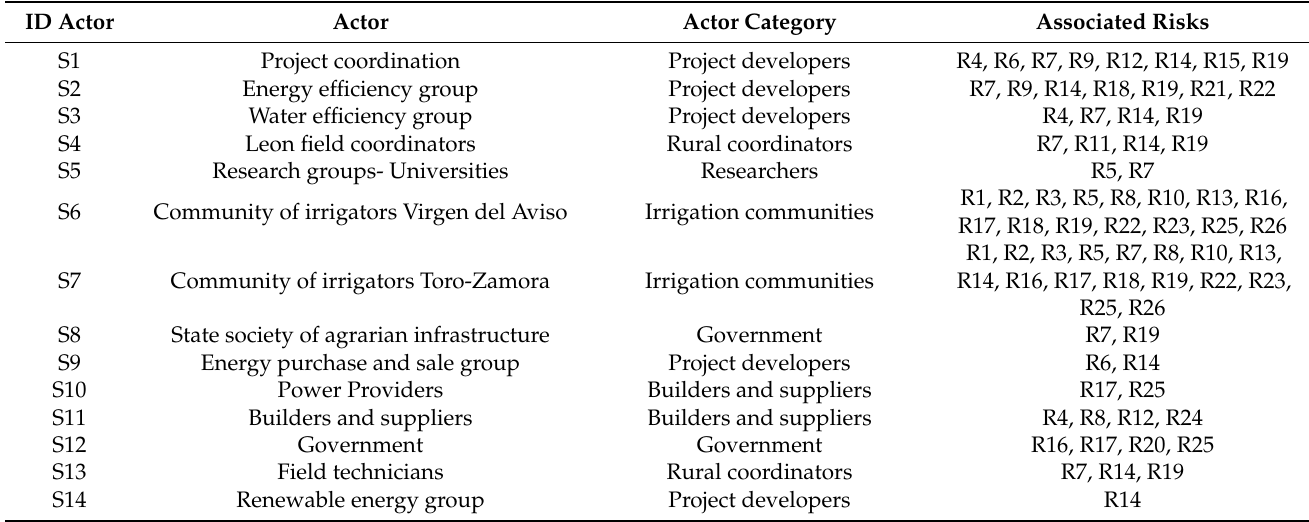
Table 4. Classification of risks by type of actor.